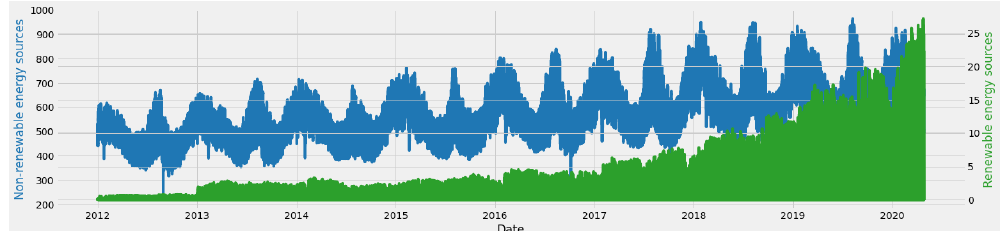
Figure 7. Comparison of renewable and nonrenewable energy